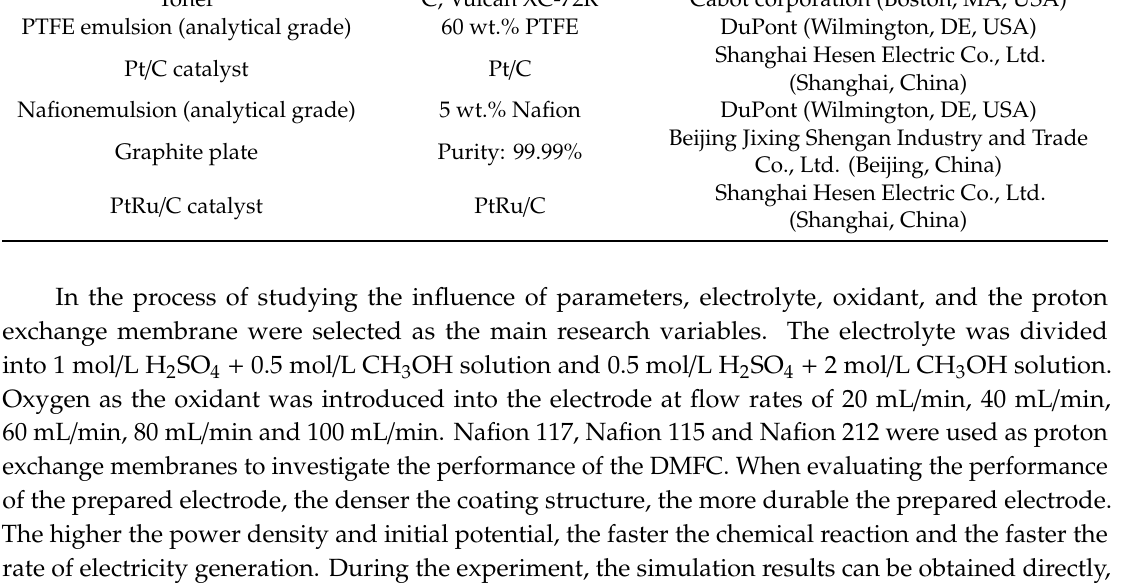
( b ) Figure 2. Coating device: ( a ) Three-dimensional design drawing of the device; ( b ) Physical picture of the device. 2.2.3. Transmission of the Coating Device According to the characteristics of the coating method, the gear was selected as the main transmission element, and the transmission mechanism is shown in Figure 3. The main shaft rotated